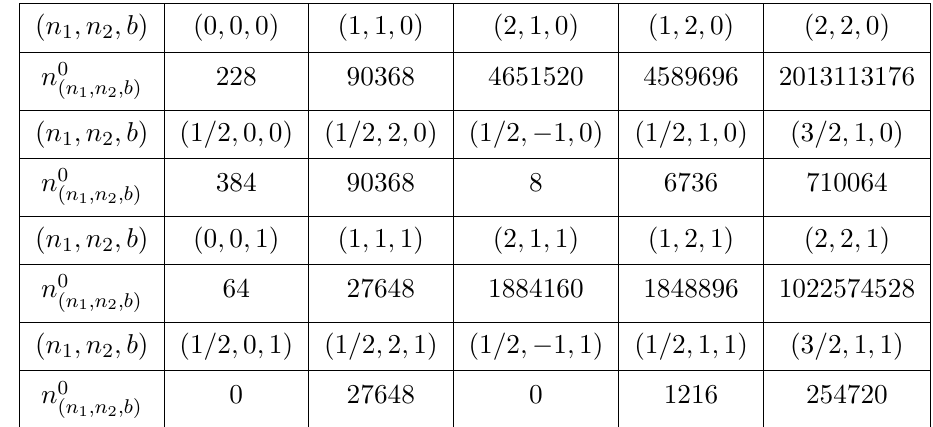
Table 8 . 2 A orbifold, non-standard embedding, with single Wilson line. Shift is given by, (cid:13) =